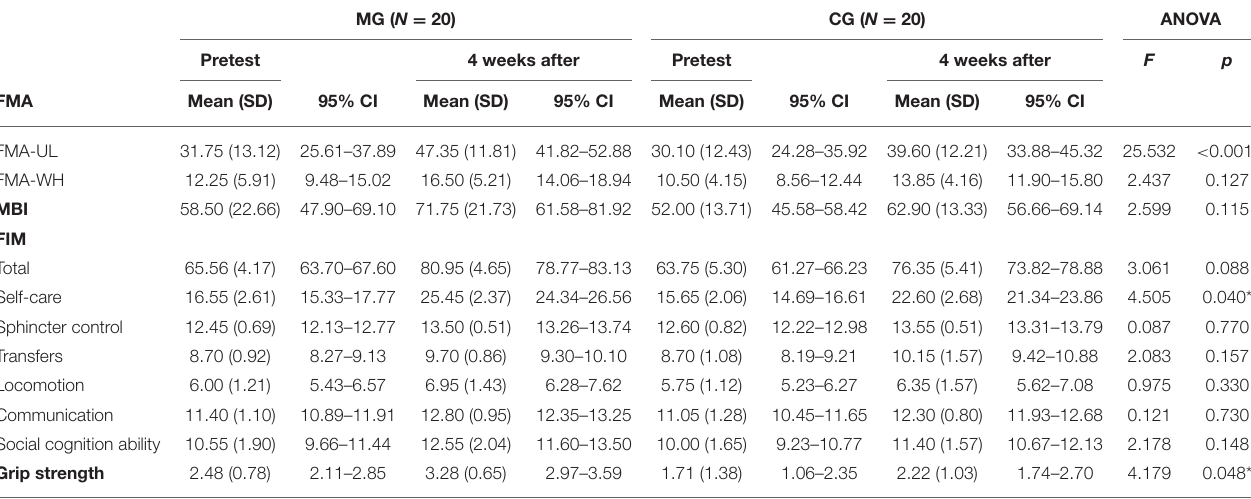
TABLE 2 | Descriptive and inferential statistics for motor impairment, daily function, and grip